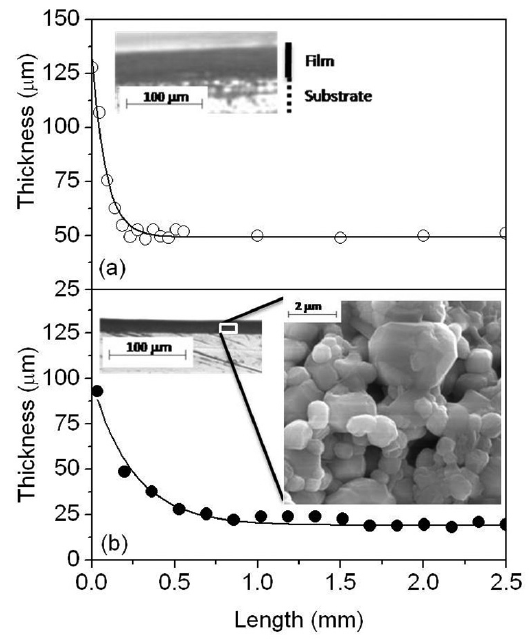
Figure 6. Thickness of the cut-cross section of the (a) deposited film Zr O BTZ25). and (b) sintered film at 1220 °C/1h (in detail is shown a cut-cross 0.75 0.25 3 section and a SEM image of the thick film). The thick films were deposited with EtOH+Acac suspension, nanoparticles concentration of 5 mg/cm 3 , deposition time of 120s and electric field of